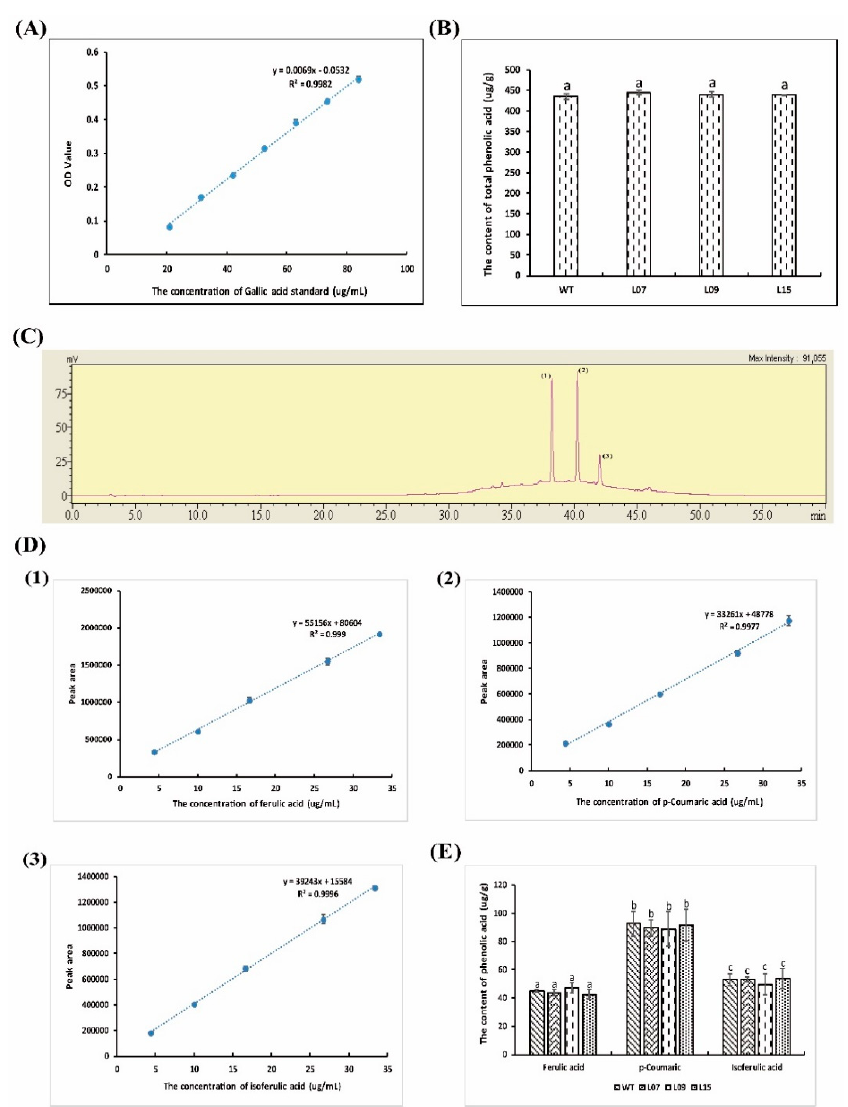
Figure 4. Phenolic acid analysis of the wild type and trans-lunasin rice. ( A ) Gallic acid standard curve in the total phenolic acid content assay. ( B ) Total phenolic acid content in the wild type and trans-lunasin rice. ( C ) Chromatographic analysis of the phenolic acid composition. ( 1 ) Ferulic acid; ( 2 ) p -Coumaric acid; ( 3 ) Isoferulic acid. ( D ) The standard curve of phenolic acids. ( 1 ) Ferulic acid; ( 2 ) p -Coumaric acid; ( 3 ) Isoferulic acid. ( E ) The composition and content of phenolic acids in the wild type and trans-lunasin rice. Data are shown as the means of three independent experiments, the bars indicate ± SD. The same letters above the columns between the different rice lines show no significant differences ( p < 0.05).